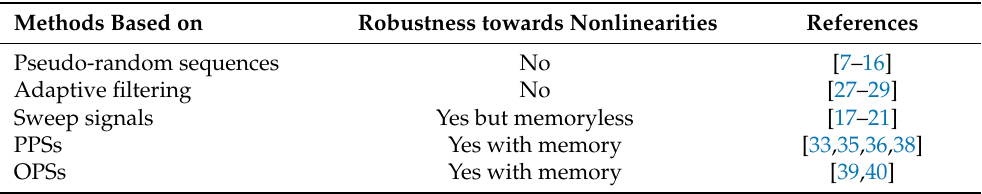
Table 1. Summary of HRTFs measurement methods proposed in the literature by category and their robustness towards